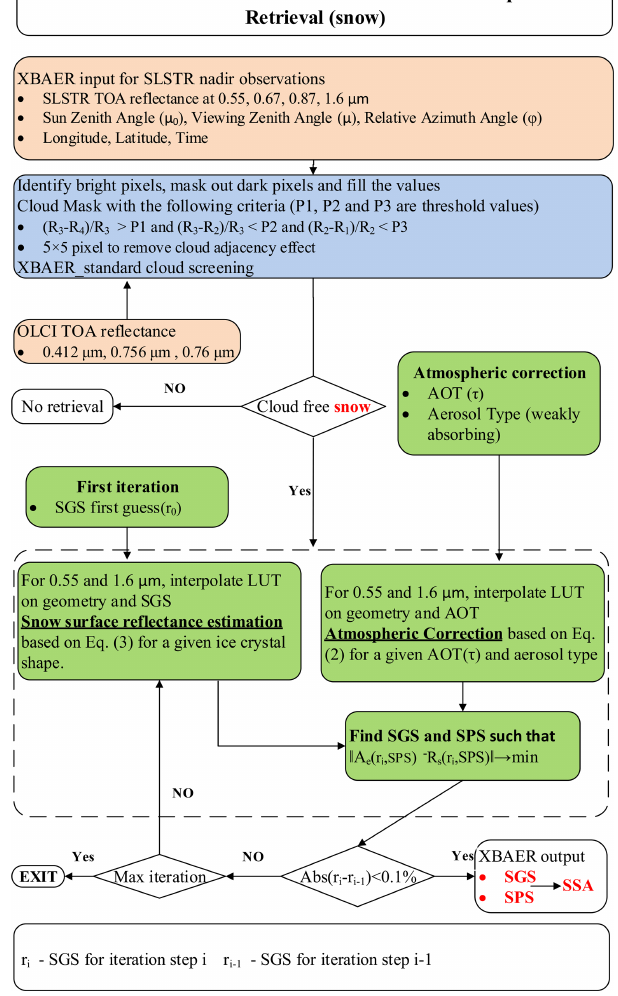
Figure 3. Flowchart of the XBAER retrieval